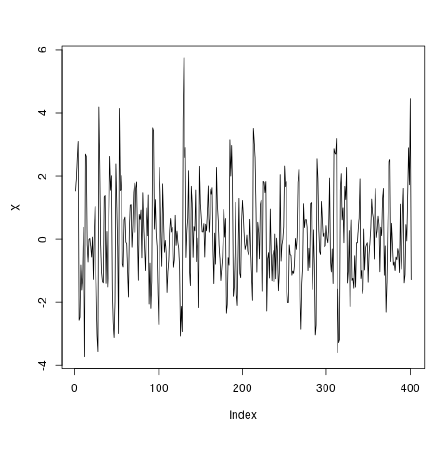
Figure 1: Simulated data.